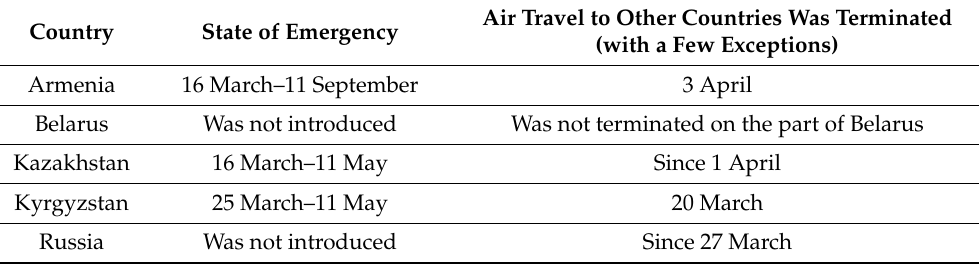
Table 1. The timeframe for the introduction of states of emergency and the termination of air travel to other countries in the EEU member States in 2020.